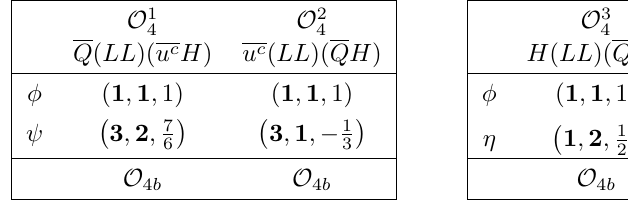
and . Note that only the operator O 4 a O 4 b